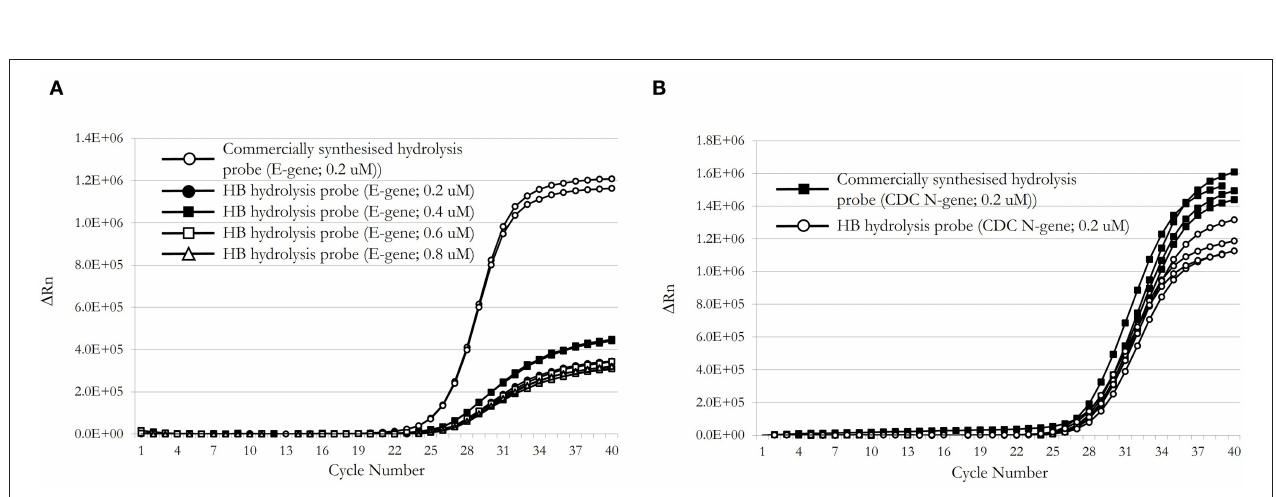
FIGURE 8 | PCR performance comparison of HB E-gene (A) and HB CDC N-gene (B) with a commercially synthesized hydrolysis probes.